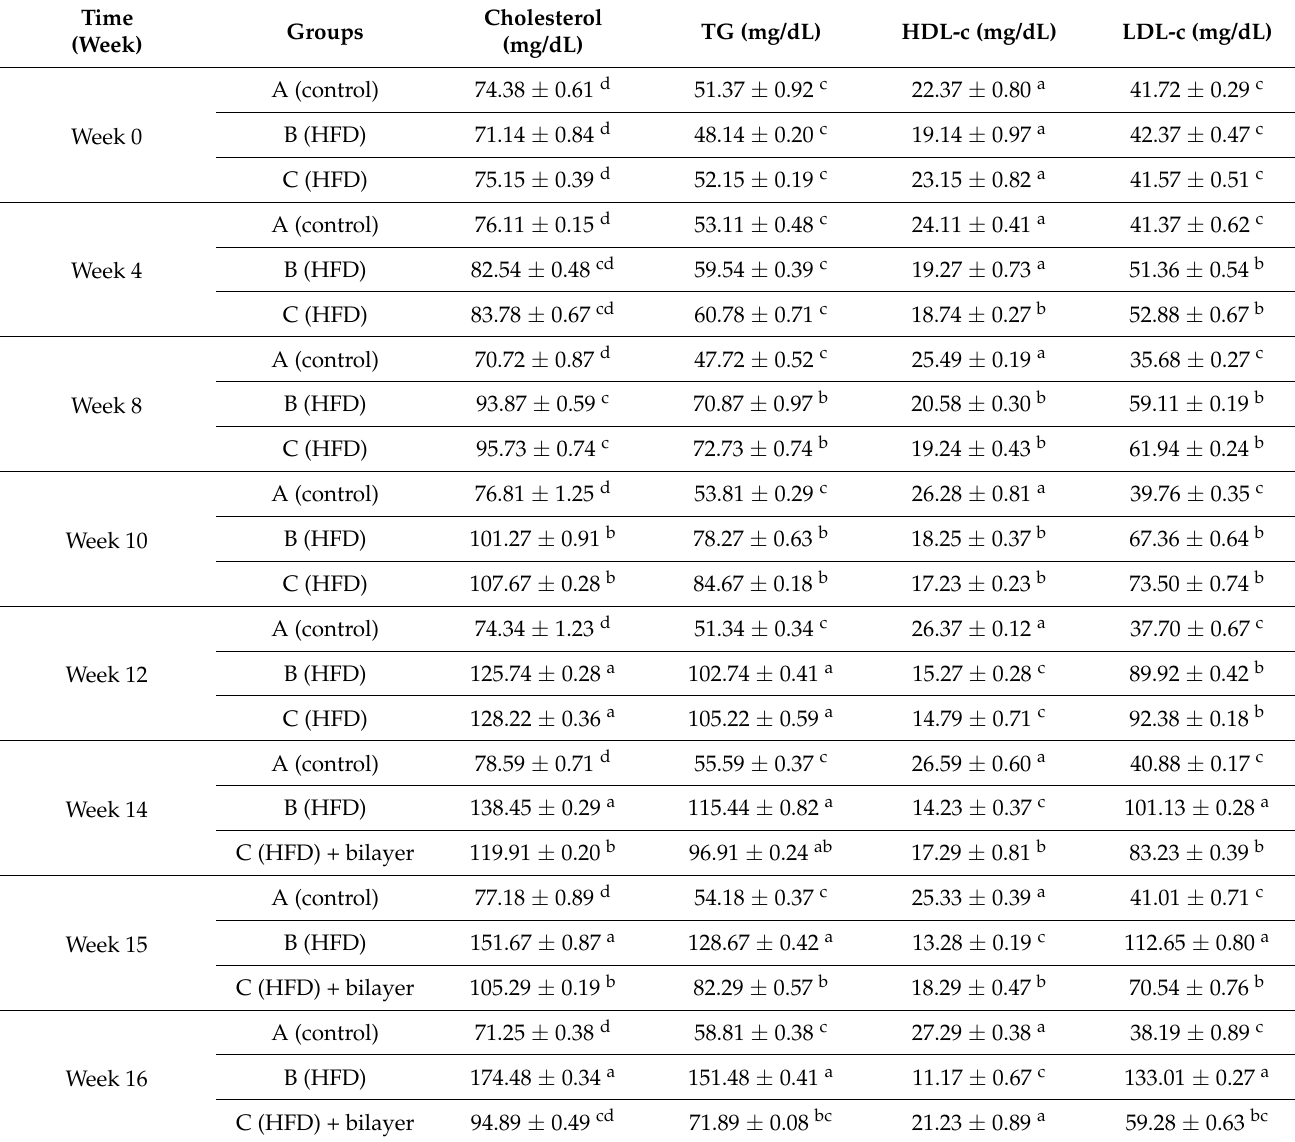
Table 11. Changes in lipid profile (mean values ± SE, n = 3) in rabbits in all groups over all the experimental